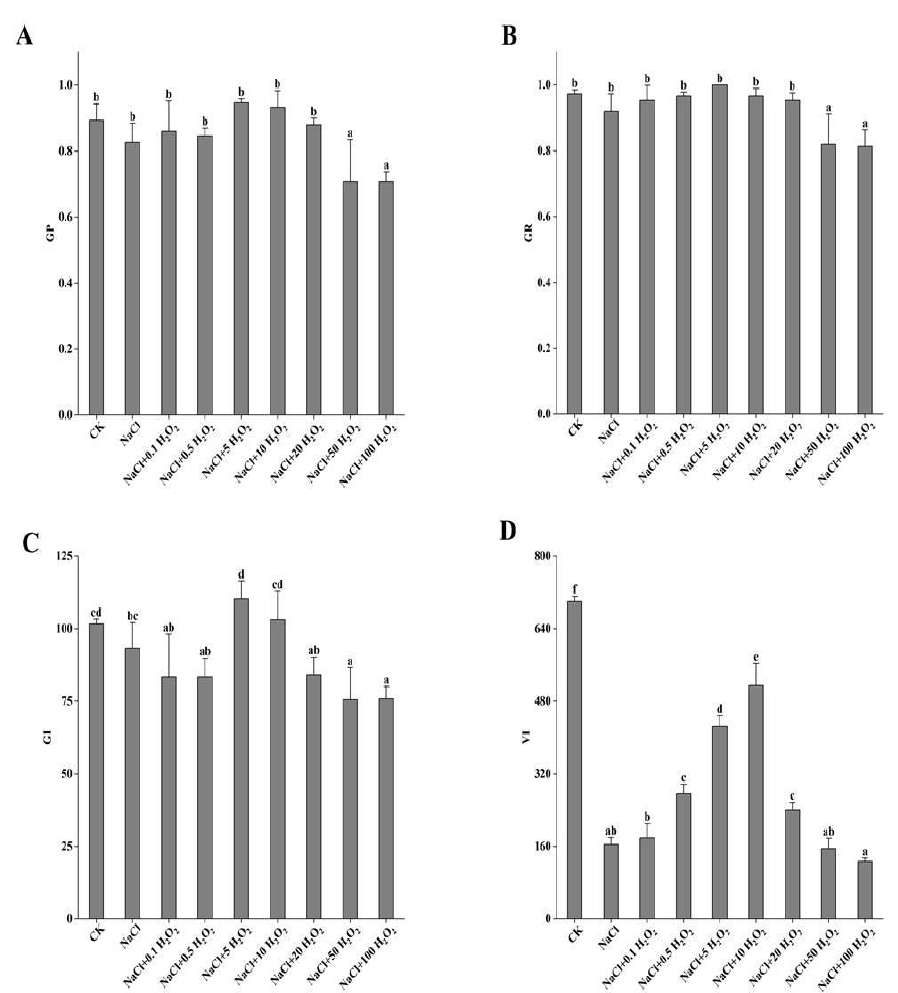
Figure 1. Effect of H 2 O 2 pretreatment on the GP ( A ), GR ( B ), GI ( C ), and VI ( D ) of F. tataricum seeds under NaCl stress. CK, control treatment (only water); NaCl, 50 mmol L −1 NaCl treatment; NaCl + xxx H 2 O 2 , treatments of standard NaCl + respective H 2 O 2 concentration; GP, germination potential; GR, germination rate; GI, germination index; VI, vigor index. Different lowercase letters on each column indicate significant differences between treatments at p < 0.05.